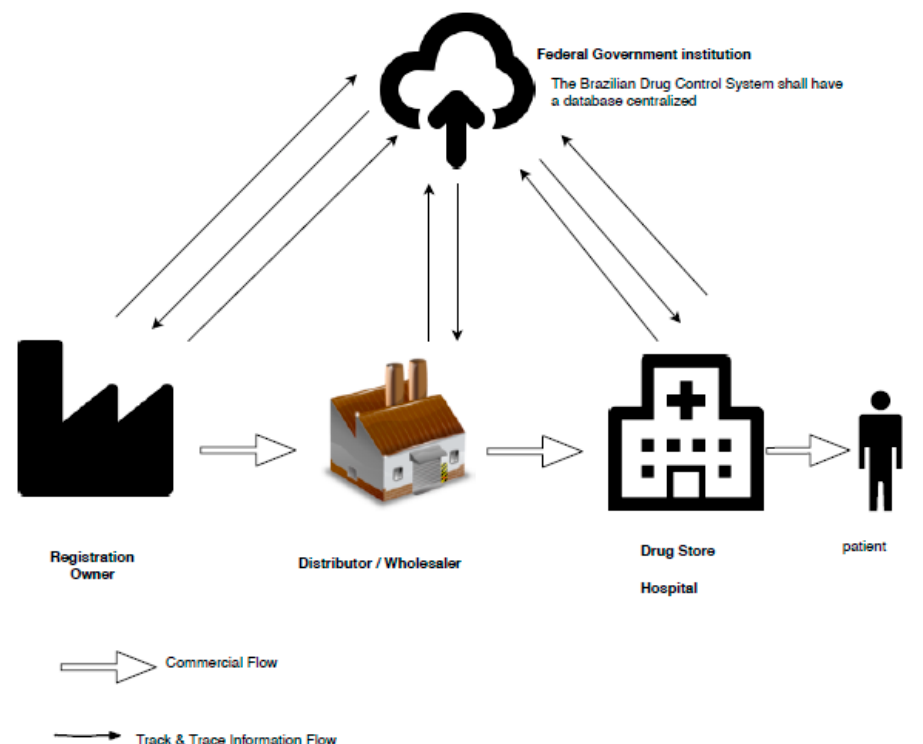
Figure 1. Traceability of medications in Brazil under the National Agency of Sanitary Vigilance (ANVISA) standard.